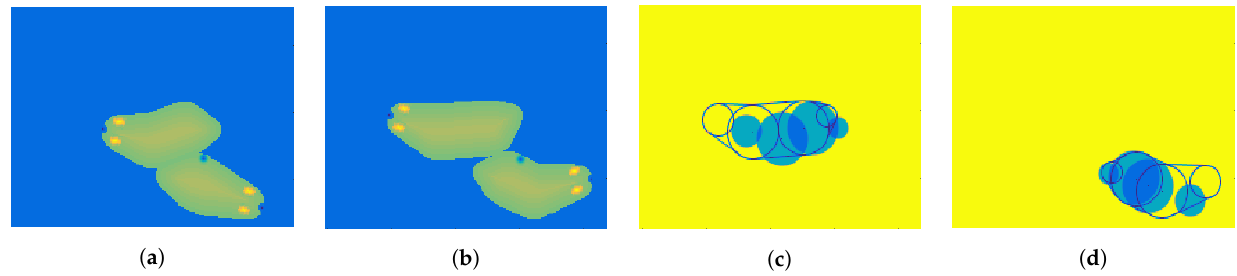
Figure 3. Images of motion simulation: ( a ) frame t and ( b ) frame t + 1 of two animals; ( c ) first and ( d ) second shape in frame t (filled circles) and in frame t + 1 (unfilled circles).